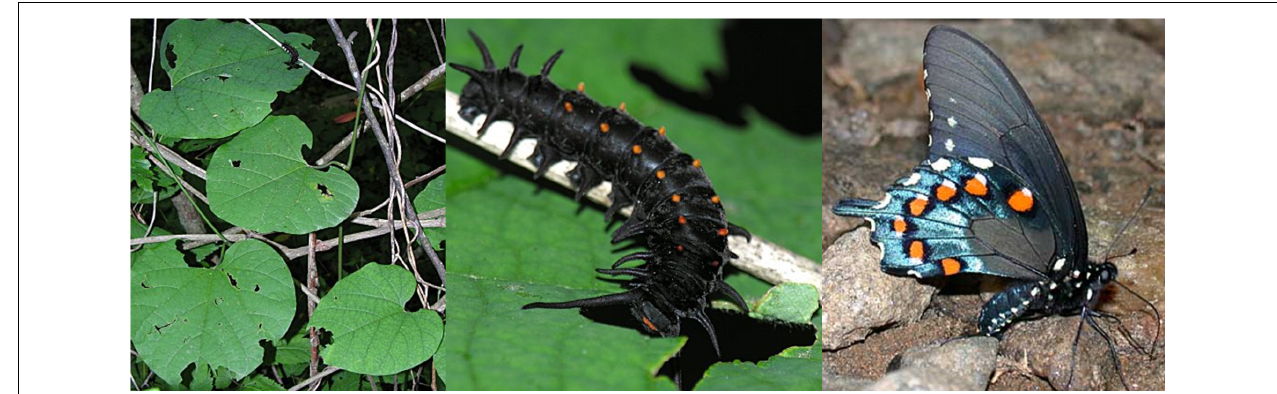
FIGURE 1 | Photos of Pipevine (Aristolochia macrophylla), Pipevine swallowtail caterpillar (Battus philenor), and Pipevine swallowtail butterfly, by Will Cook, Duke University.